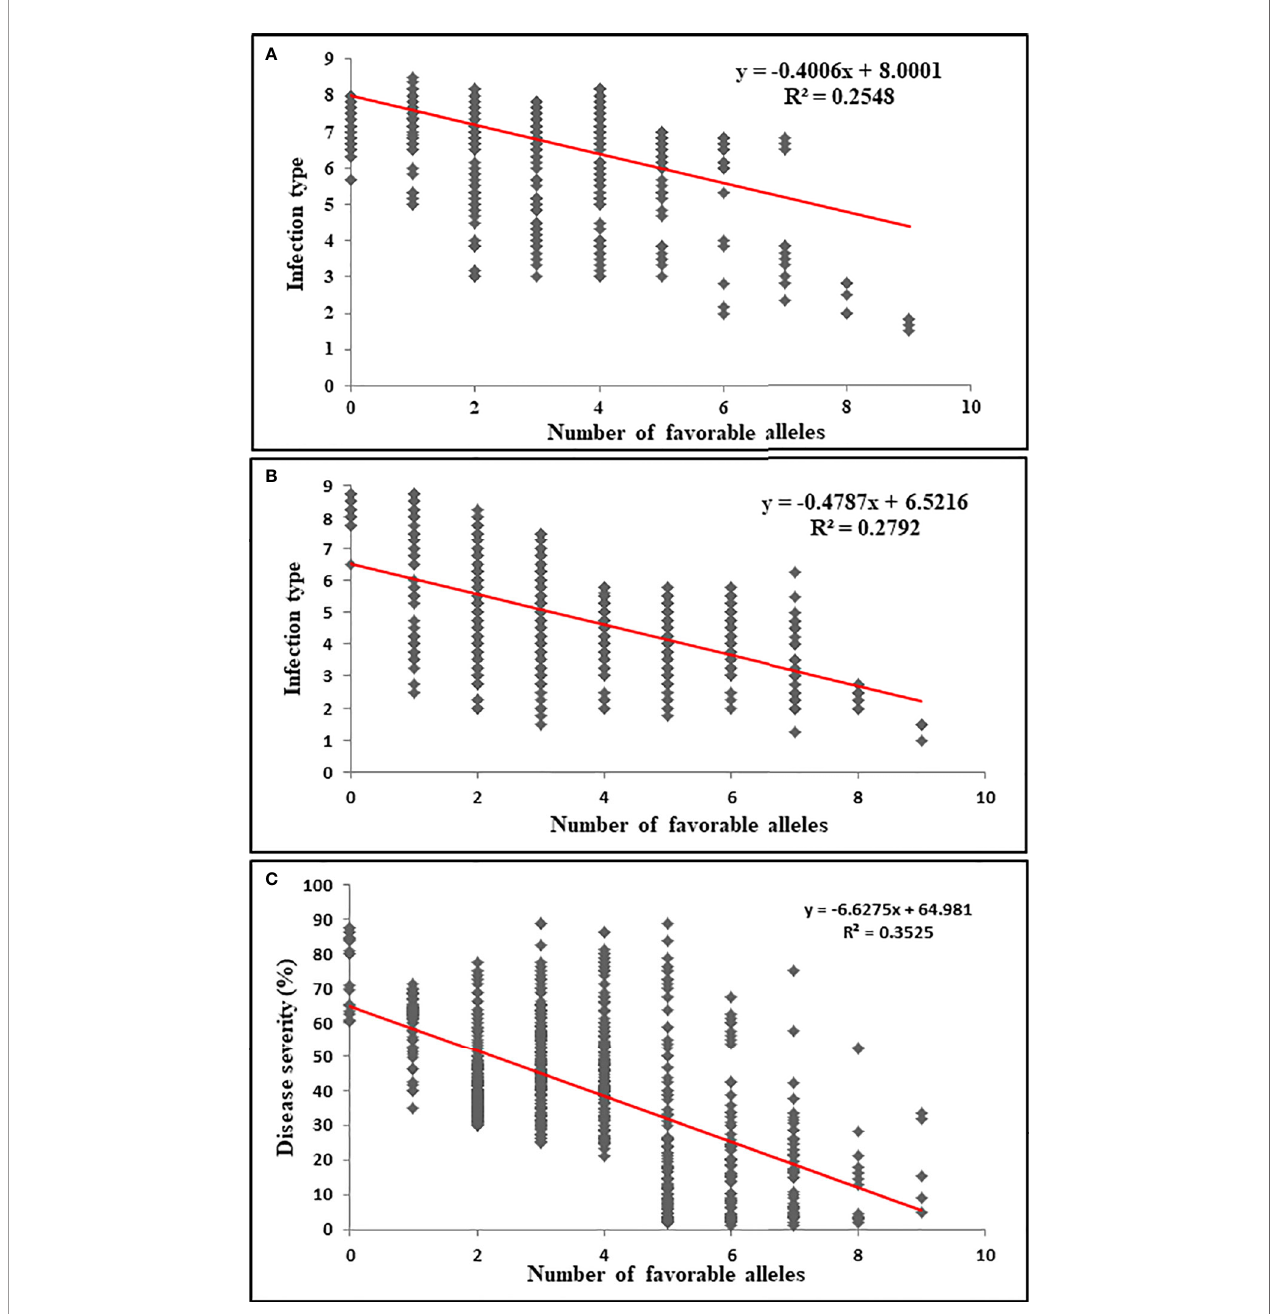
FIGURE 6 | The effect of pyramiding multiple resistance alleles of stripe rust resistance genes or QTL identi fi ed in this study. Scatter plots of the number of resistance alleles versus IT data averaged across the seedling tests (A) , IT data averaged across the fi eld tests (B) , and DS data averaged across the fi eld tests (C)